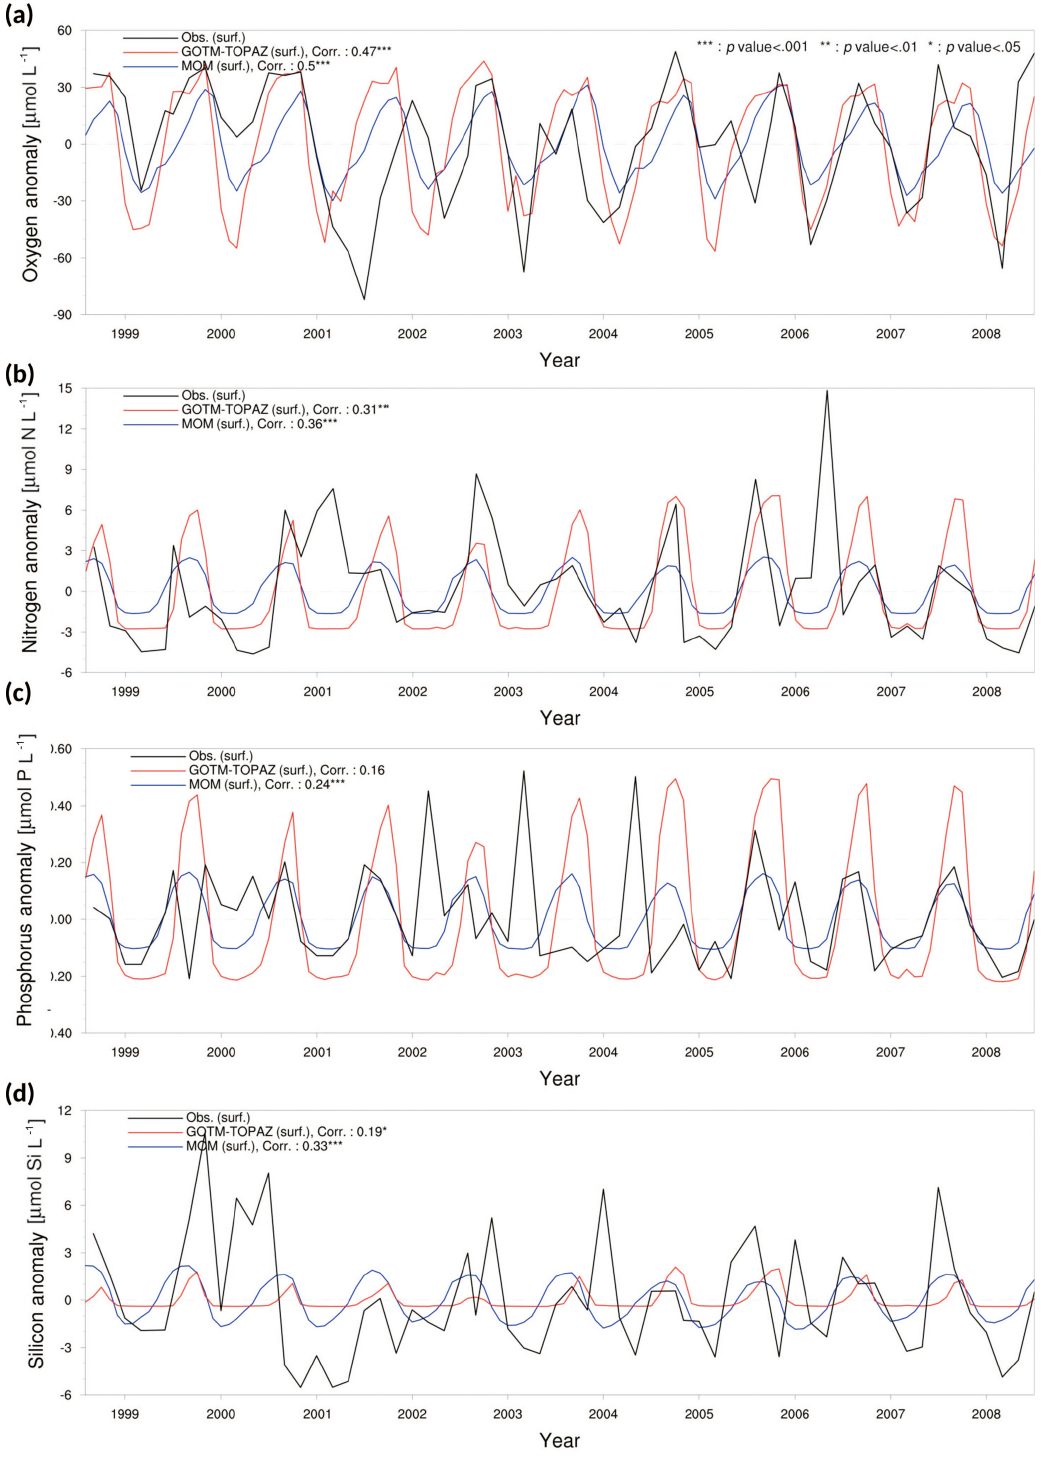
Figure 5. Anomaly time series and correlation values from observational data (black lines), MOM results (blue lines), and GOTM–TOPAZ results (red lines) for concentrations of (a) dissolved oxygen, (b) nitrogen, (c) phosphorus, and (d) silicon at point 107 for the 10-year period of 1999–2008; in this figure, nitrogen, phosphorus, and silicon include NO 3 , PO 4 , and SIO 4 , respectively.